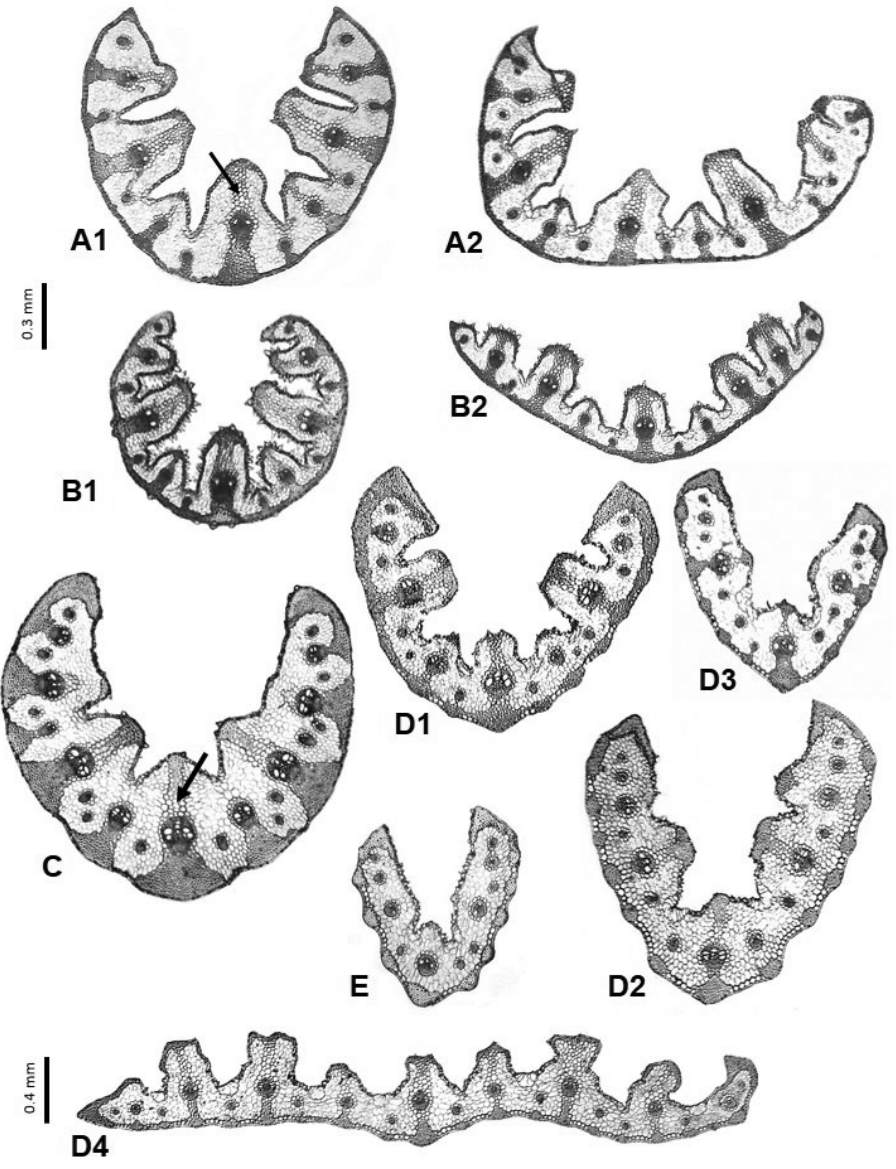
Figure 8. Leaf cross-sections of the Festuca sects. Pseudoscariosa ( A ), Scariosae ( B ) and Subbulbosae ( C–E ) species. A F. pseudeskia ( A1 conduplicate leaf, arrow pointing to the colourless cells; A2 flat leaf) B F. scariosa ( B1 conduplicate leaf, B2 flat leaf) C F. baetica (arrow pointing to the colourless cells) D F. pa- niculata s.l. ( D1 subsp. multispiculata , D2 subsp. fontqueri , D3 subsp. paui , D4 subsp. longiglumis ) E F. durandoi . Scale bars: 0.3 mm ( A–E ), and 0.4 mm ( D4